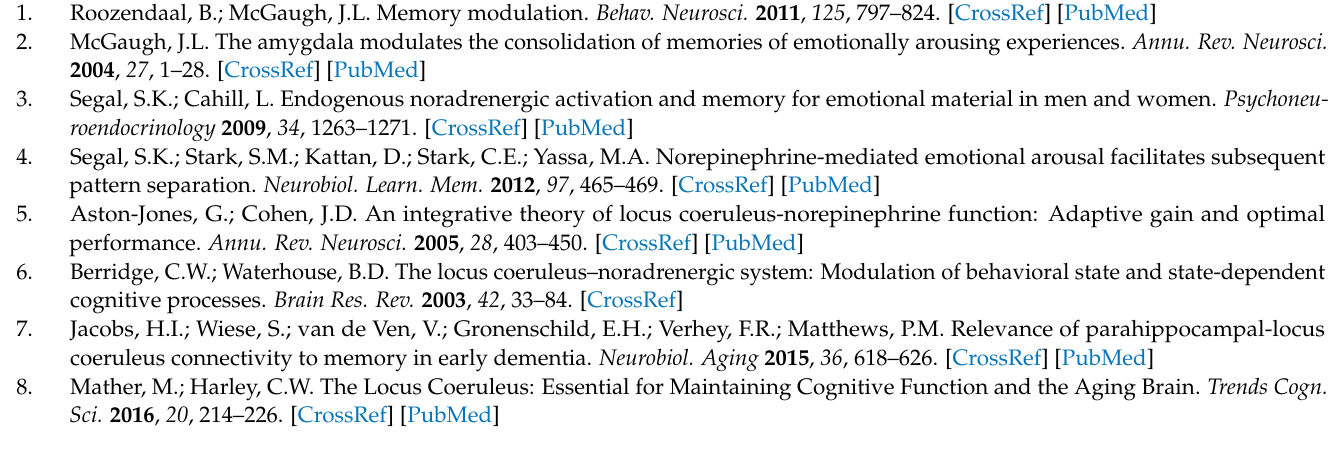
Figure S2: The association between Worry and Depression score, Figure S3: Violin plot showing the distribution of the mean activation per ROI divided by arousal level, Figure S4: Violin plots showing the distribution of the mean activation per ROI divided by hits and FP. Figure S5: The scan of the LC in template